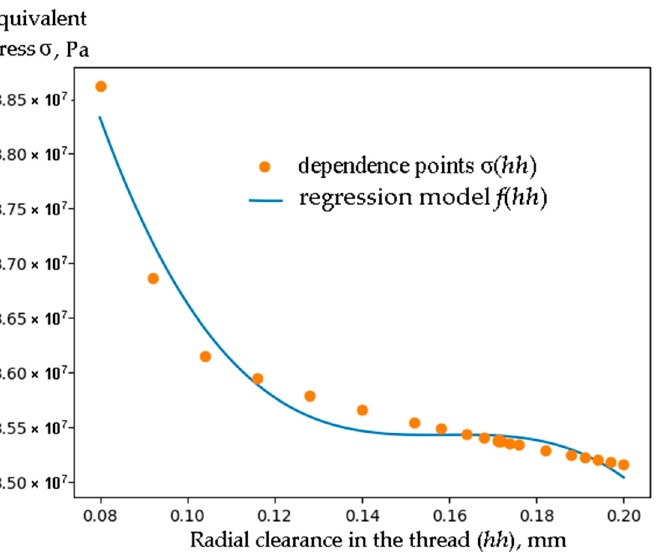
Figure 9. Dependence points σ ( hh ) obtained during optimization and regression model f ( hh ). Calculating the minimum of the function σ ( hh ) in this way on a computer with an Intel Xeon CPU E5-2630L v3 (eight cores) took 17 min, which is 5.6 times faster than the sequential execution of tasks for the 23 values of x . The maximum CPU load is 64% and RAM is 20 GB. In most cases, this optimization method allows us to immediately obtain the regression equation f ( hh ):